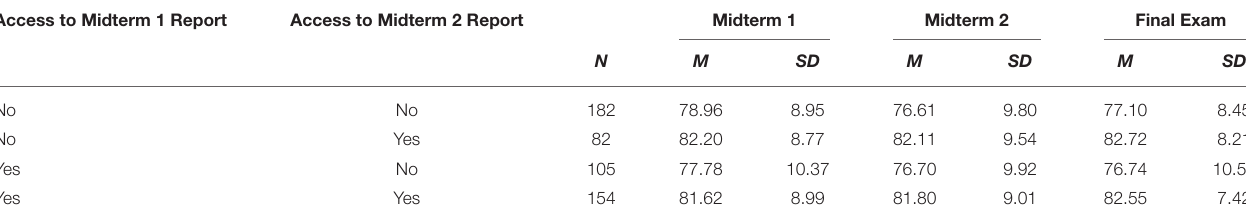
TABLE 2 | Descriptive statistics for the percent-correct scores by students’ access to score